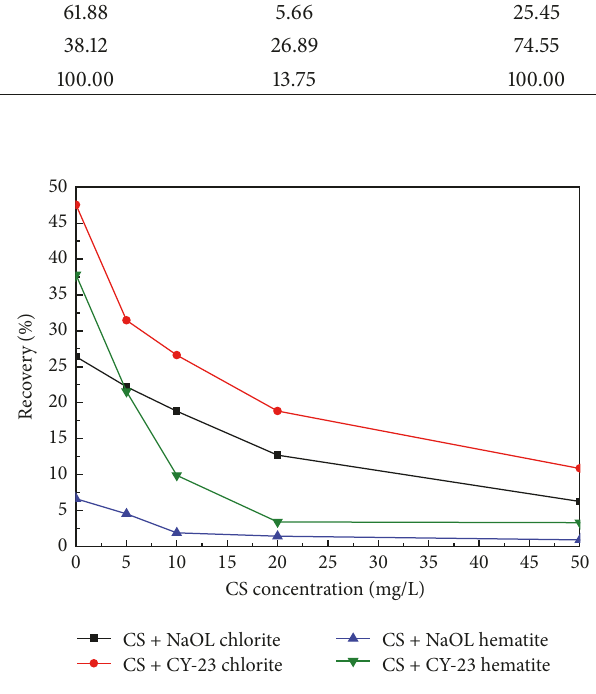
Figure 2: Effect of pH on the flotation recovery of chlorite and hematite in the absence of CS {𝑐 (NaOL, CY-23) = 50 mg/L } .